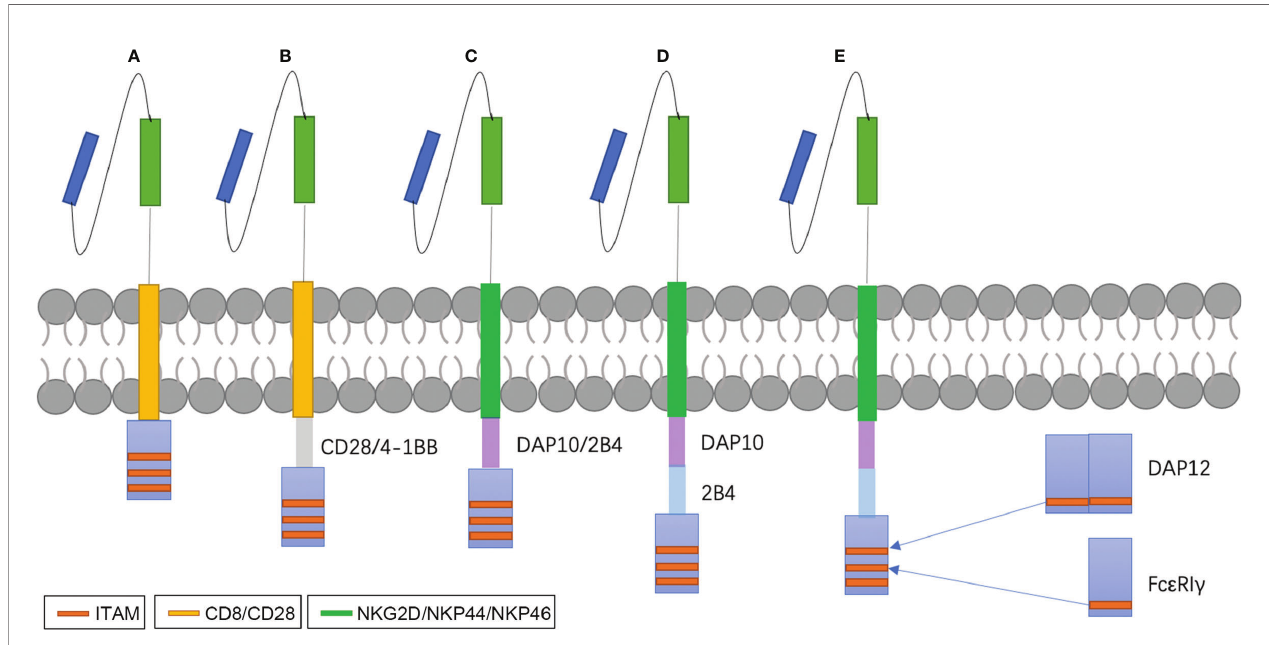
FIGURE 2 | NK-CAR designs. Early studies exploring CAR-NK cells used CAR constructs optimized for T cell signaling and function (A, B) . Later, many investigators begin to study costimulatory domains speci fi c for NK cell signaling, such as DAP10, DAP12 or 2B4 (C, D) . DAP10 is the adaptor molecule of NKG2D and acts via a Syk-independent regulatory pathway (92). DAP12 is the adaptor molecules of NKG2C, NKp44 and activating killer immunoglobulin receptors (KIRs) and contain immunoreceptor tyrosine-based activation motifs (ITAMs) (93). 2B4, an important co-stimulation factor of NK activation, contains immunoreceptor tyrosine-based switch motifs (ITSMs) that recruit adaptor molecules such as SLAM-associated protein (SAP) to mediate signal transduction (94). We design a new CARs that replace ITAMs of CD3 z with Fc ϵ RI g and DAP12 (E)